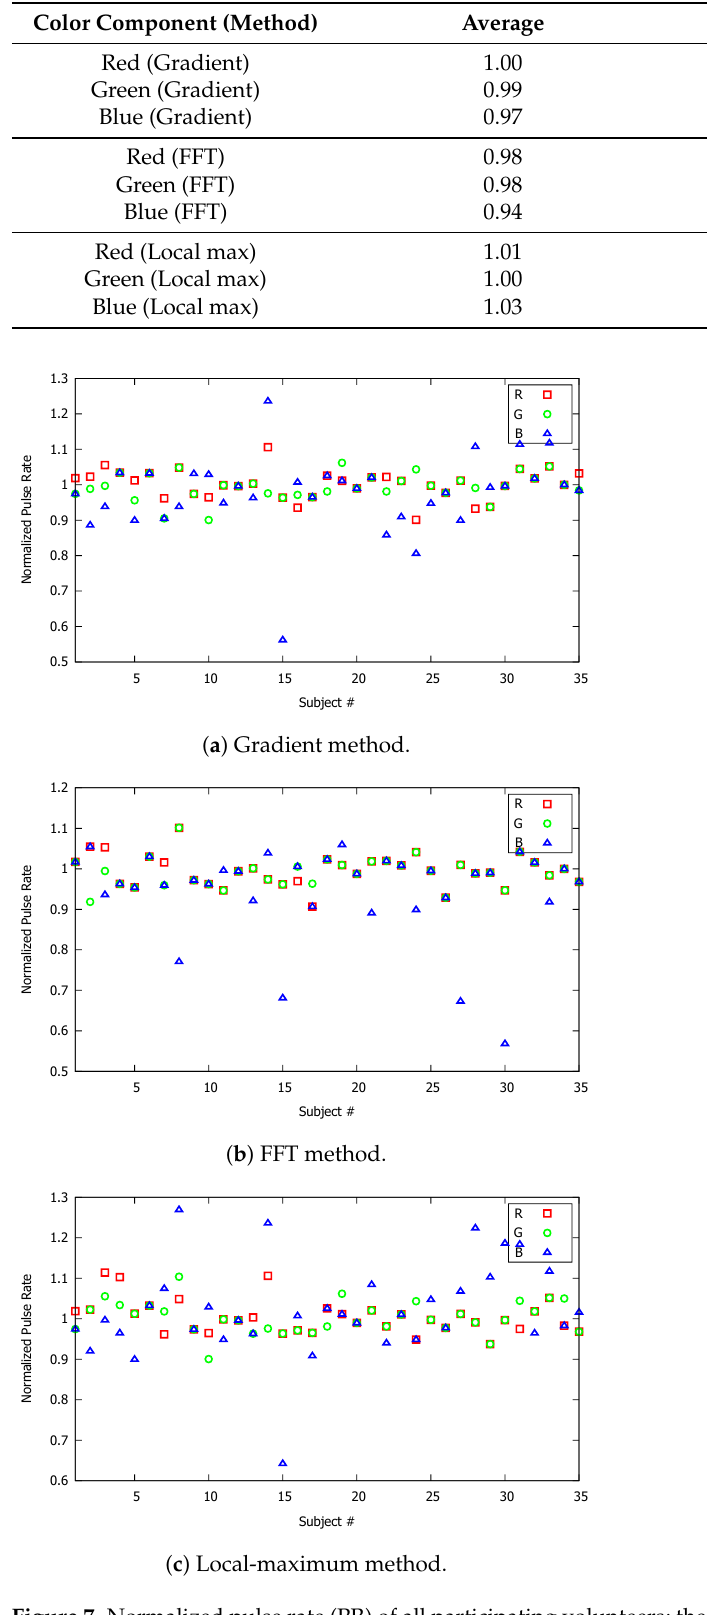
Figure 7. Normalized pulse rate (PR) of all participating volunteers; the video recording time in these graphs corresponds to 30